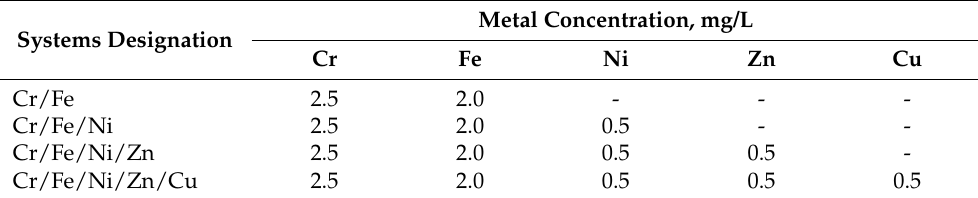
Table 1. Multi-metal systems’ chemical